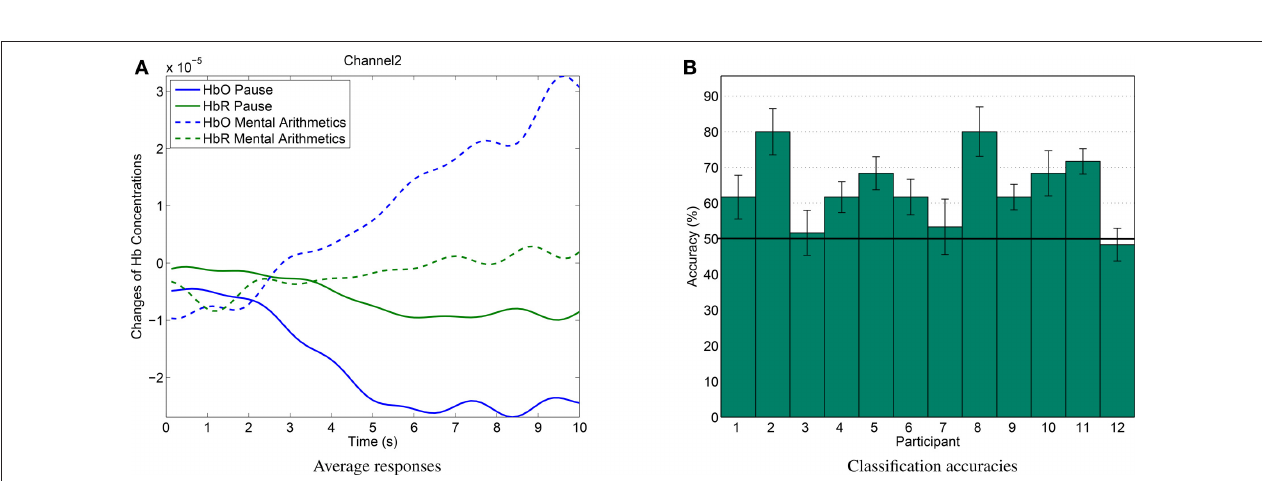
FIGURE 9 | (A) Average hemodynamic response over all subjects during mental arithmetics and pause. (B) Classification results for single-trial discrimination between pause and mental arithmetics. Whiskers indicate standard errors. Solid line shows chance level.